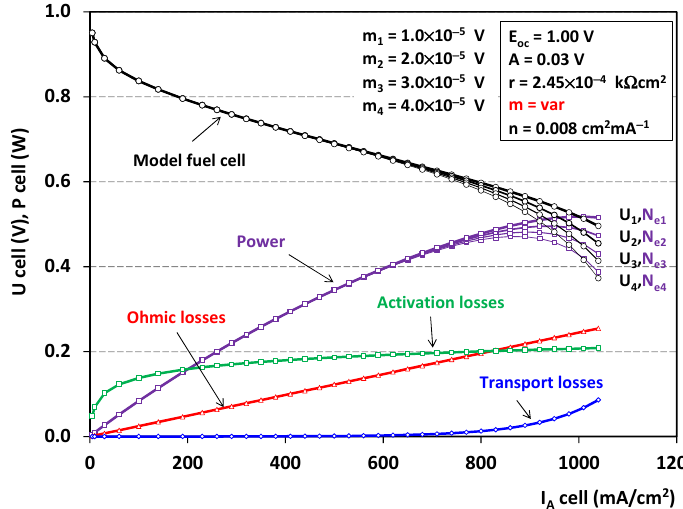
Figure 8. Impact of changes in mass m on the I–U characteristic and fuel cell power.